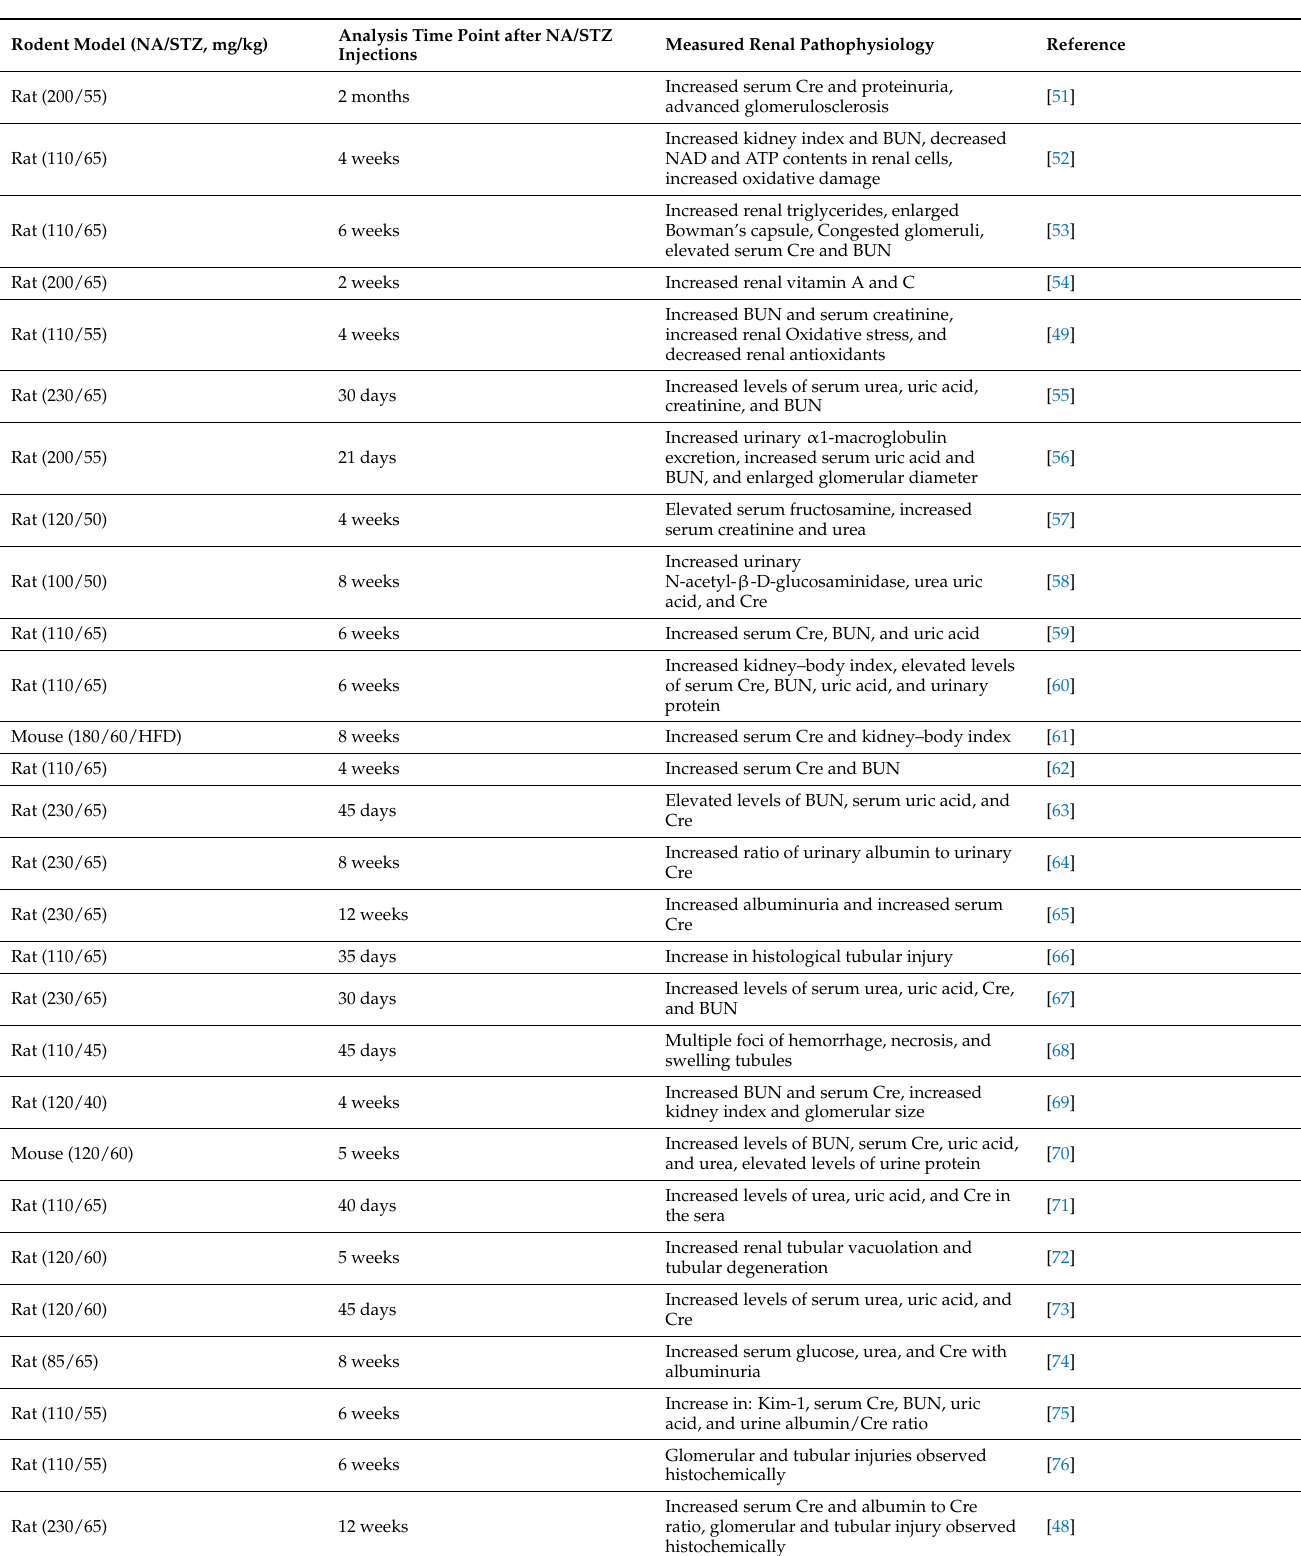
Table 2. Renal pathophysiology in the NA-STZ rodent